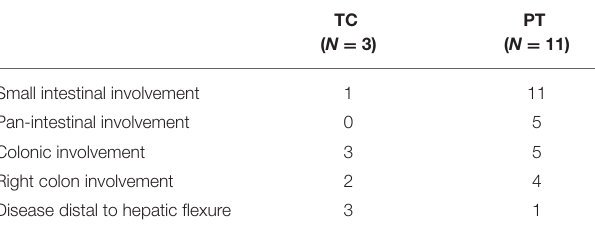
TABLE 4 | Anatomical distribution of